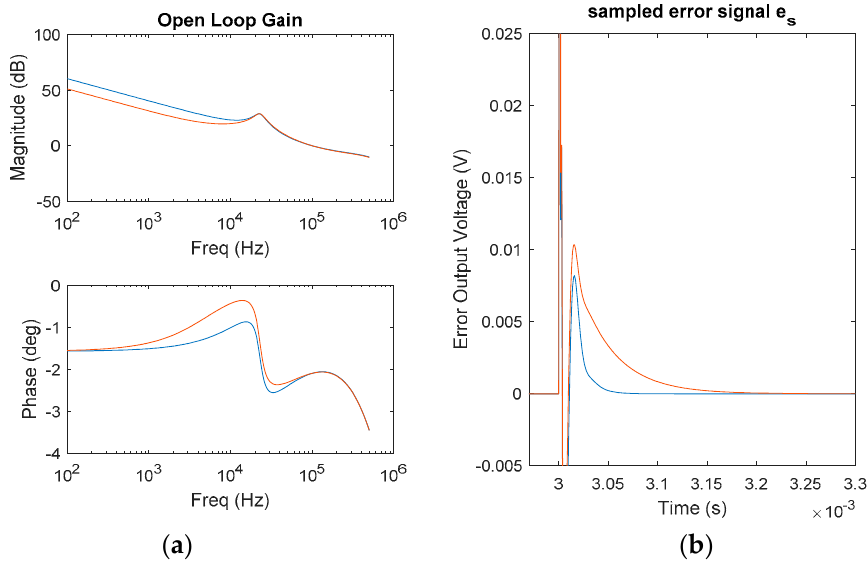
Figure 4. ( a ) Open-loop gain T, corresponding to two different designs of PID2 with the same ( f c , PM ) and different parameter values of K 2 ; ( b ) error signal in the time domain when a step in the reference voltage is applied.